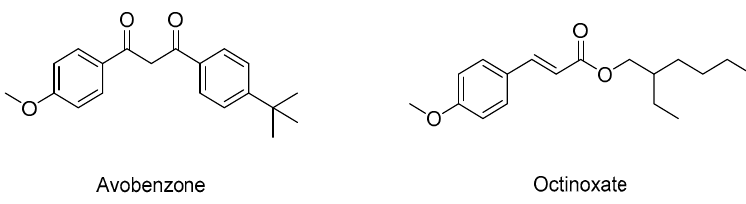
Scheme 1. Structures of two common commercial organic filters used in